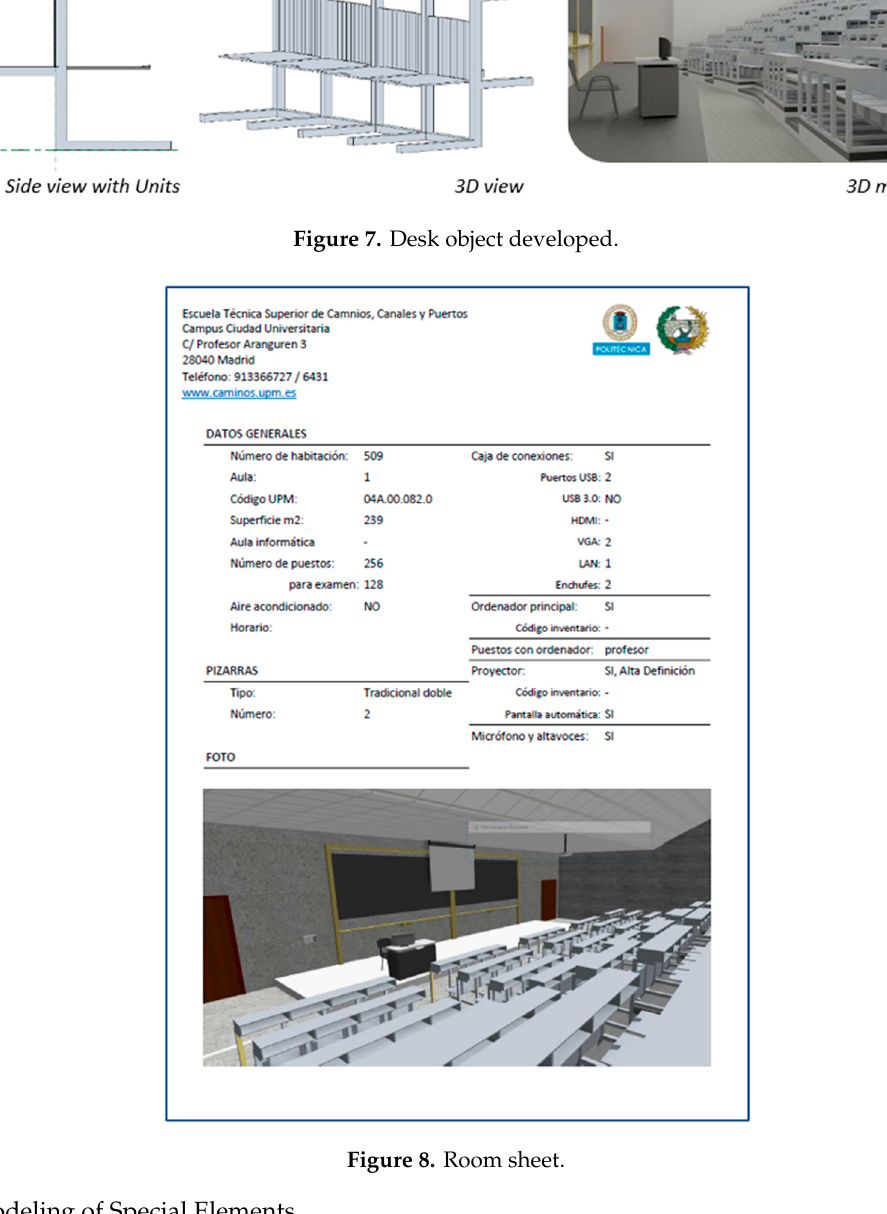
Figure 9. High detailed locations.